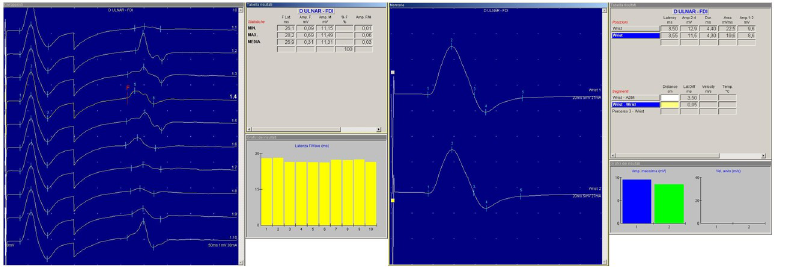
M = amplitude ratio between F-wave and M-wave amplitudes; Amp. M = M-wave amplitude; Amp. massima = maximum amplitude; D ULNAR FDI = ulnar nerve recorded from the right first dorsal interosseous muscle; Dur. = duration; F Lat. = F-wave latency; Latenza = latency; MAX. = maximum value; MEDIA = mean value; MIN. = minimum value; % F = F-wave